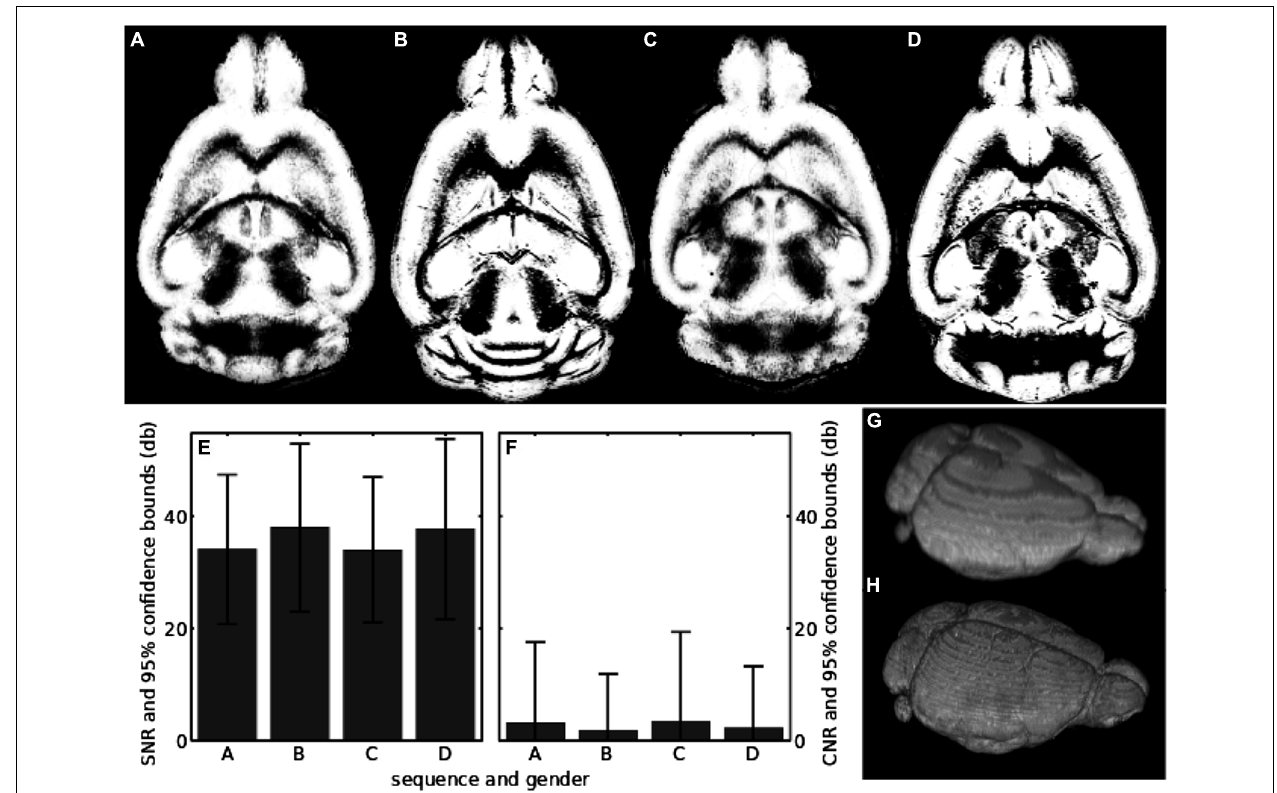
axis show which sequence and mouse has been analyzed and correspond to the upper row of the figure; (F) the same as in E , but for the CNR; (G) volume visualization of the in vivo segmentation result shown in A ; (H) volume visualization of the post-mortem segmentation result shown in B .